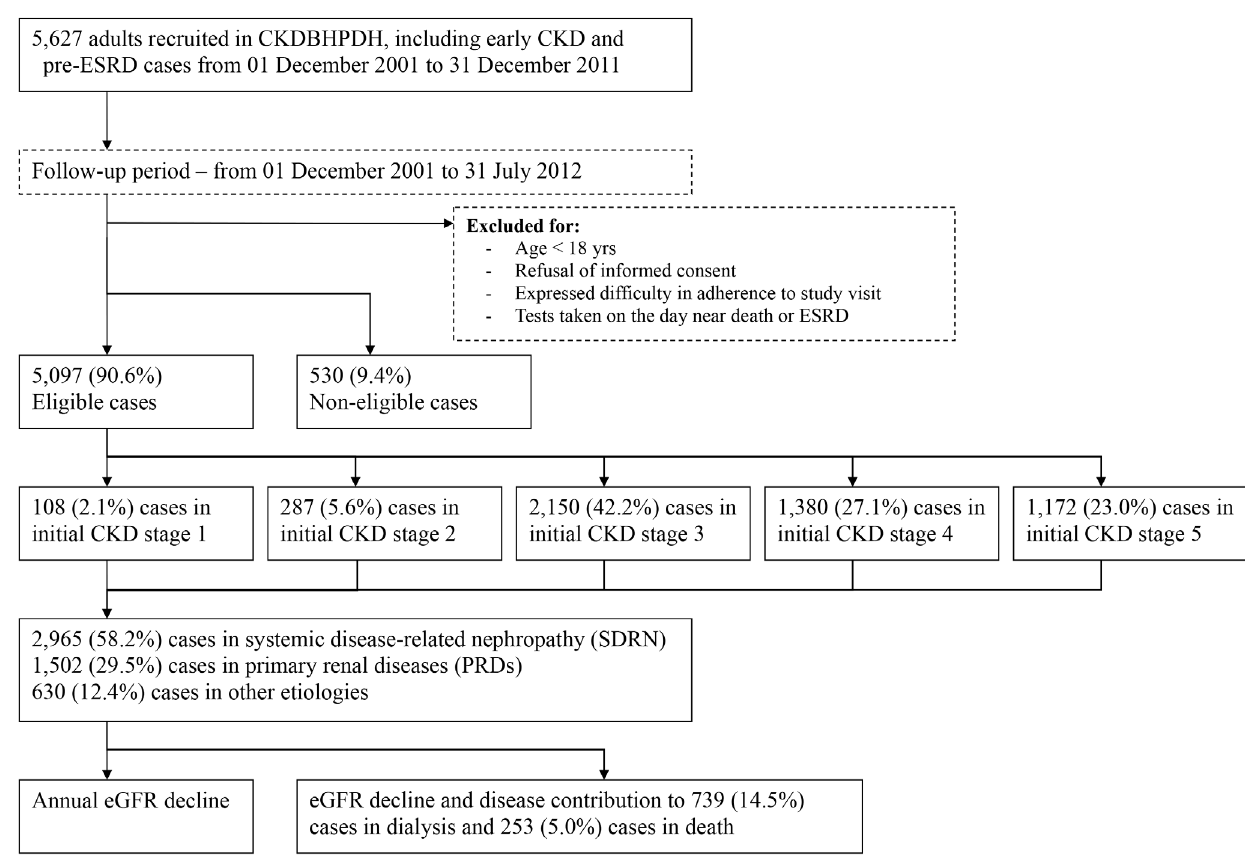
Figure 1. Study diagram of study cohort.